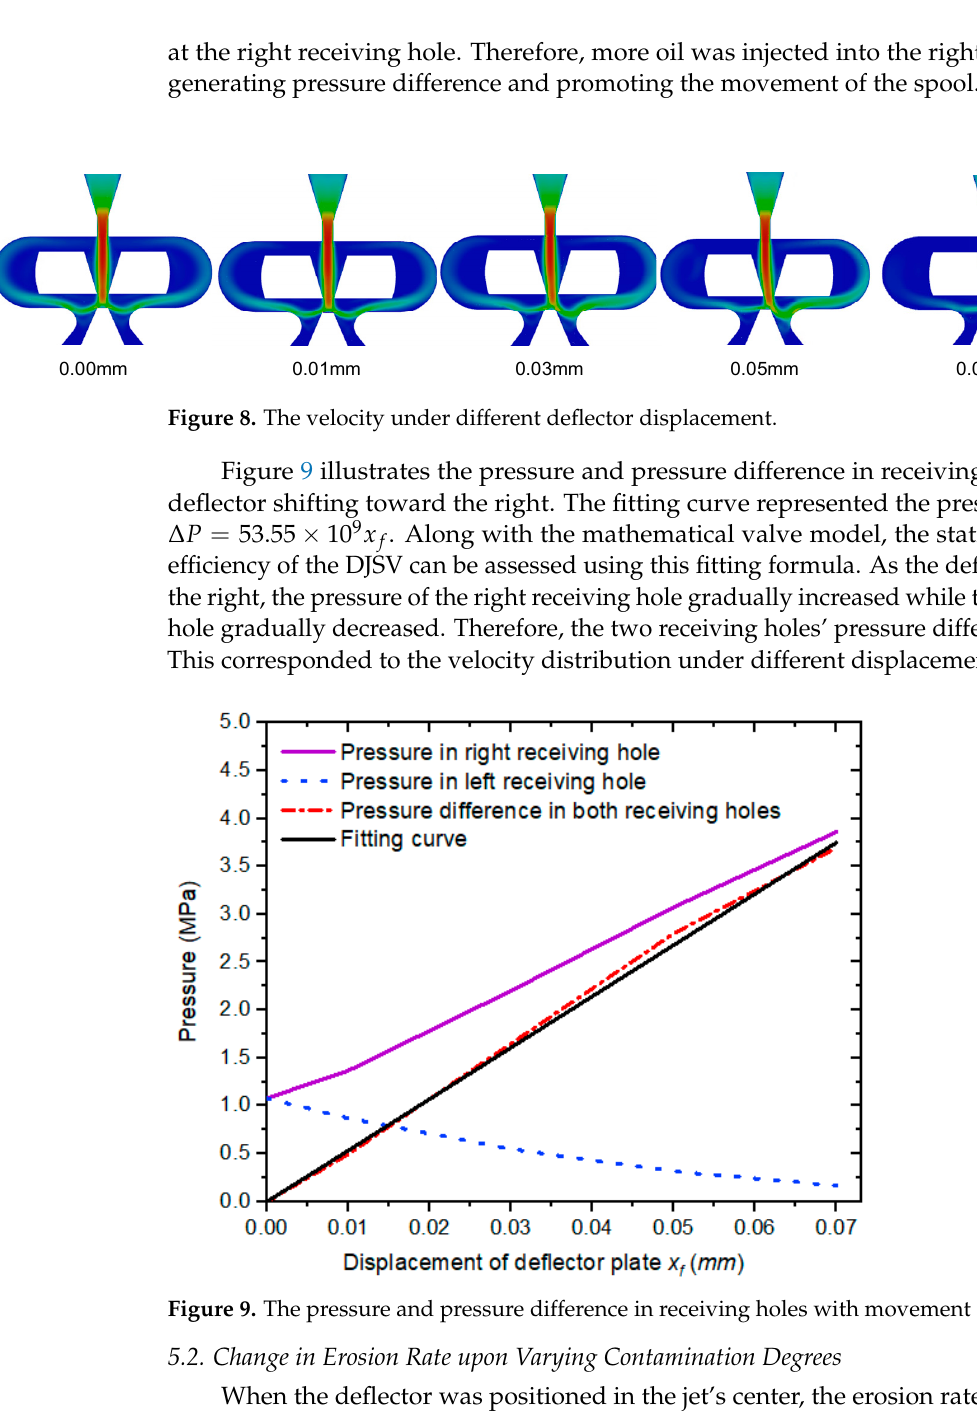
12 of 20 Figure 7. Distribution curve of d Y under level ‐ 7 contamination degree. Table 3. Rosin–Rammler distribution parameters of particles. Contamination Degree